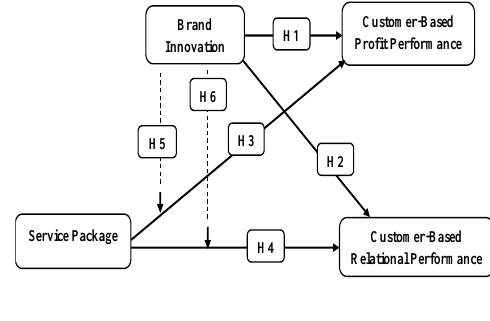
Figure 1. Conceptual